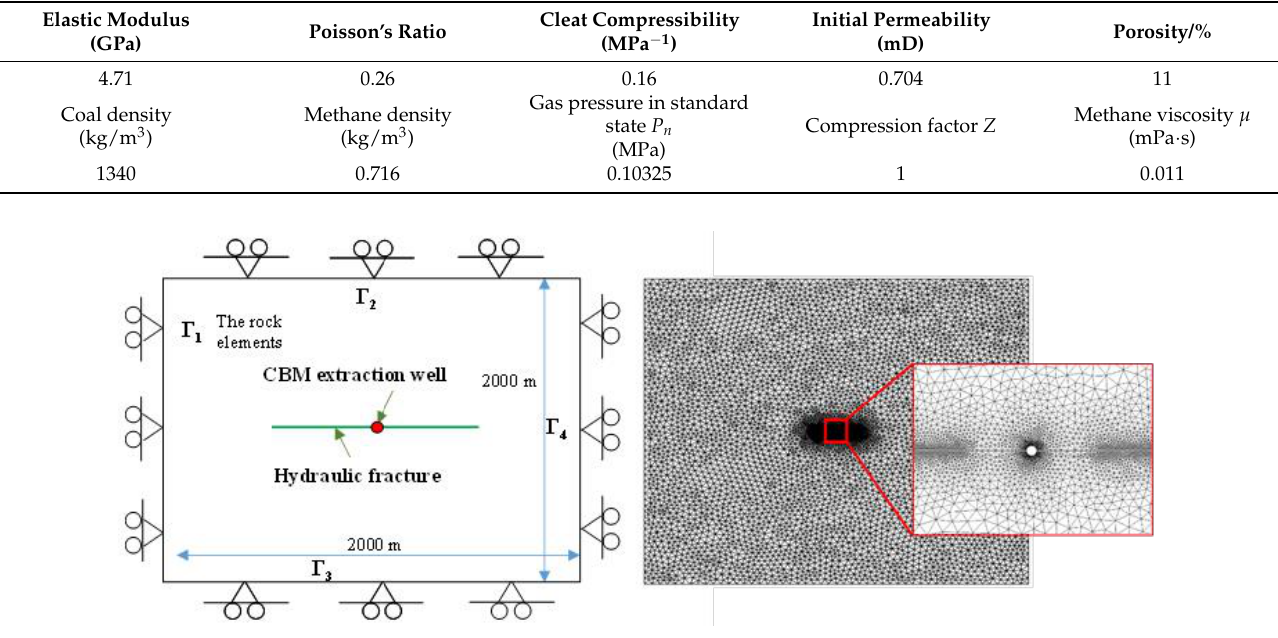
Table 1. Main model parameters.